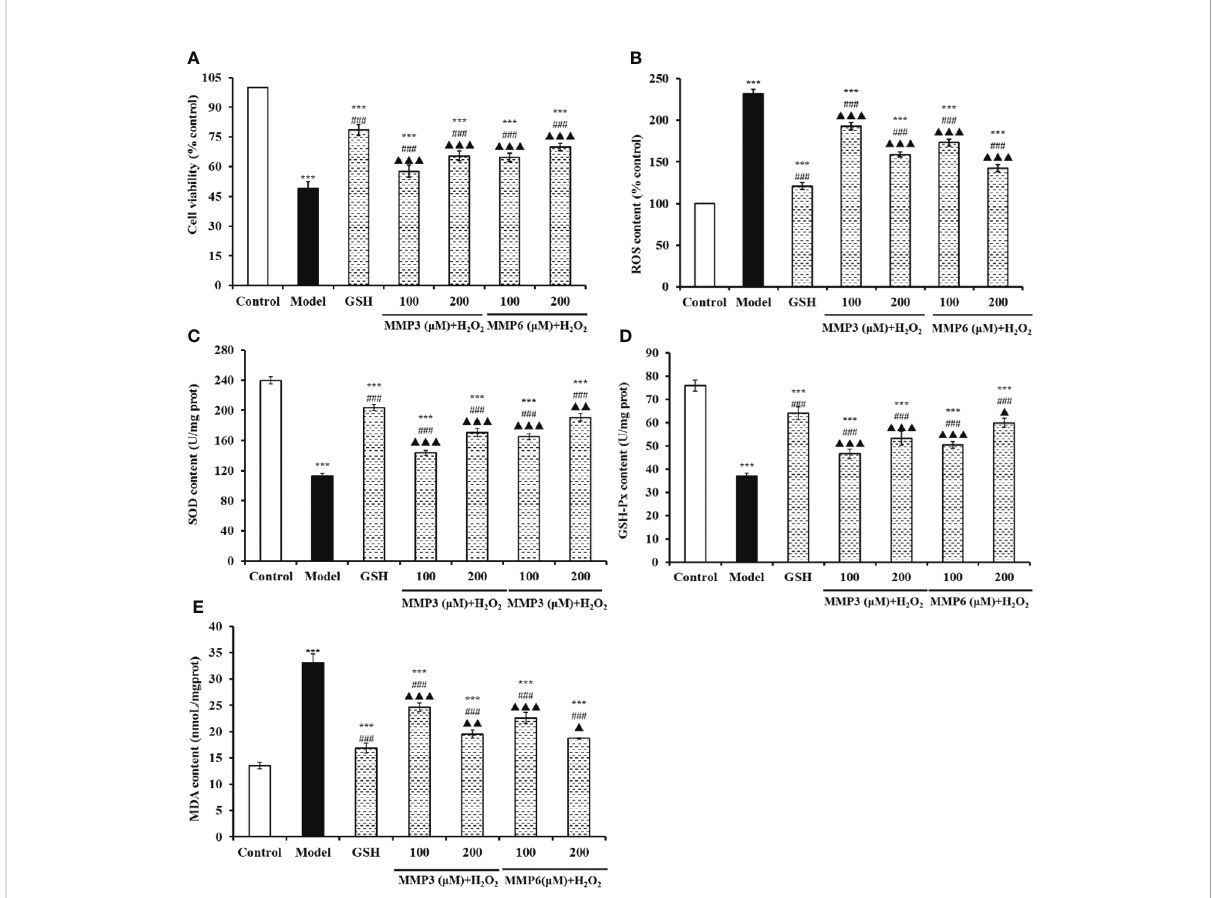
FIGURE 7 Effects of MMP3 and MMP6 on the cell viability (A) , ROS (B) , SOD (C) , GSH-Px (D) , and MDA (E) of H 2 O 2 -induced HUVECs. All values are means ± SD (n= 3). GSH was designed as a positive control. *** P < 0.001 < 0.01 VS control; ### P < 0.001 VS model; ▲▲▲ P < 0.001 VS